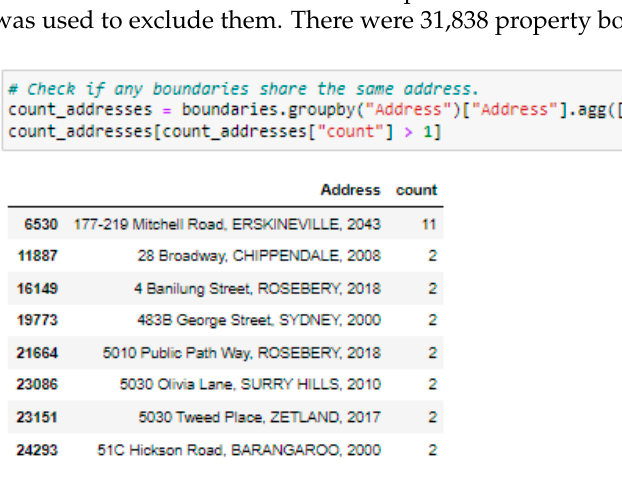
Figure 13. List of categories and uses included in each category.